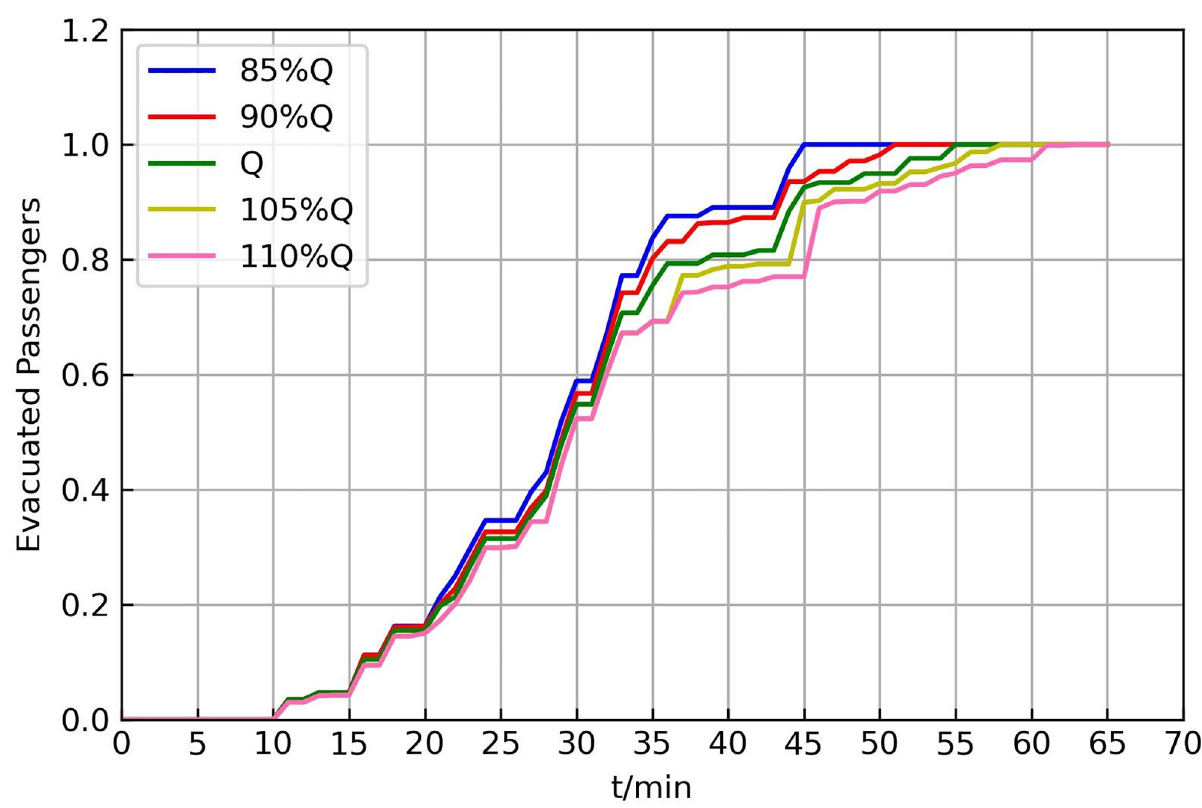
Fig 9. Resilience curves for different evacuation